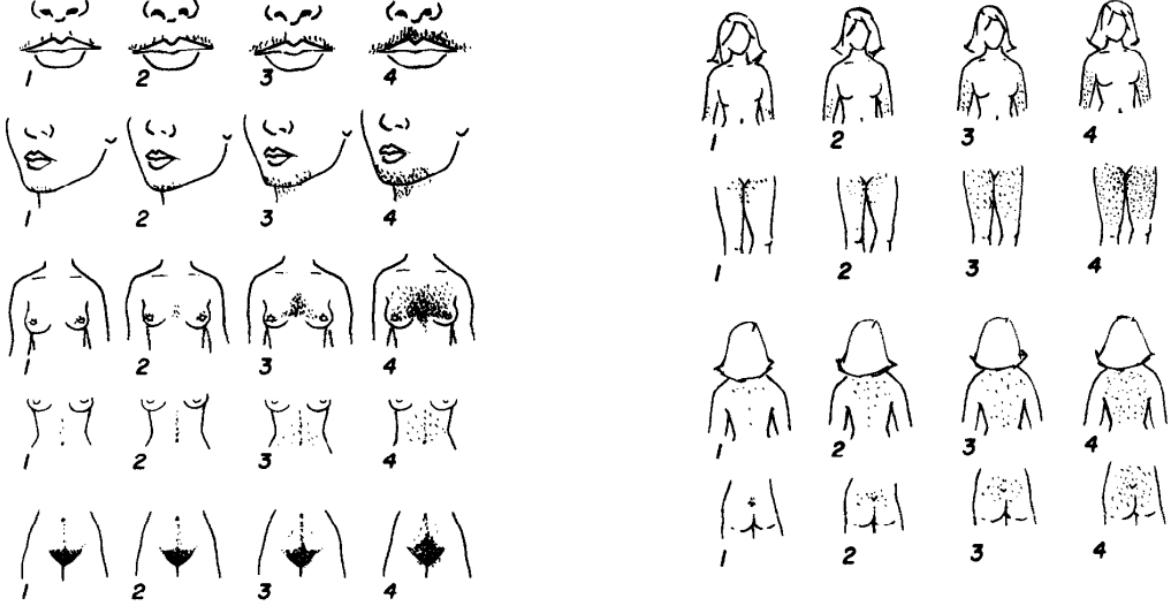
Figure 1. Hirsutism scoring system presenting scores ranking from 1—minimal hirsutism, to 4 virilization in 9 body parts. A total score of less than 8 is considered normal, whereas higher scores indicate mild to severe hirsutism [88].